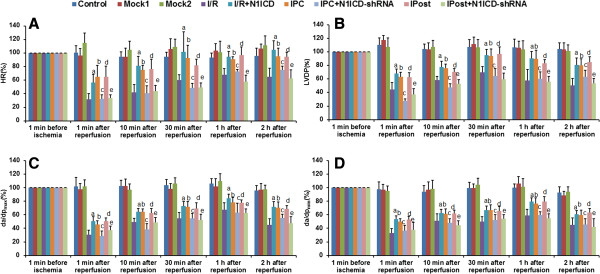
Notch1 signaling improves cardiac function in isolated rat hearts. A-D, Measurement of heart rate (HR), left ventricular developed pressure (LVDP) and maximal (dP/dtmax) and minimal (dP/dtmin) value of the first derivative of left ventricular pressure. Data were shown as the percentage of the values recorded at 1 min before ischemia. Data were presented as mean±SD, n=6. a: I/R+N1ICD vs I/R; P<0.05; b: IPC vs I/R, P<0.05; c: IPC vs IPC+shRNA, P<0.05; d: IPost vs I/R, P<0.05; e: IPost vs IPost+shRNA, P<0.05.